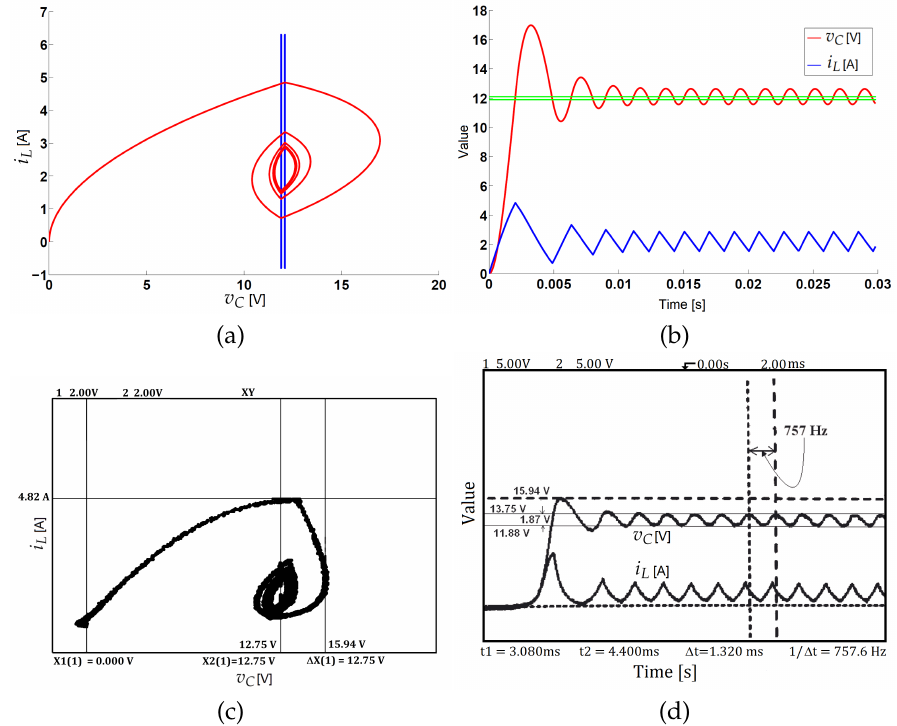
Figure 25. Experimental validation of voltage control using the constant hysteresis control for ξ = 0.2 V, converging to 1 T -periodic orbit in CCM: ( a ) phase portrait, ( b ) time evolution for simulation results, ( c ) phase portrait, and ( d ) time evolution for experimental